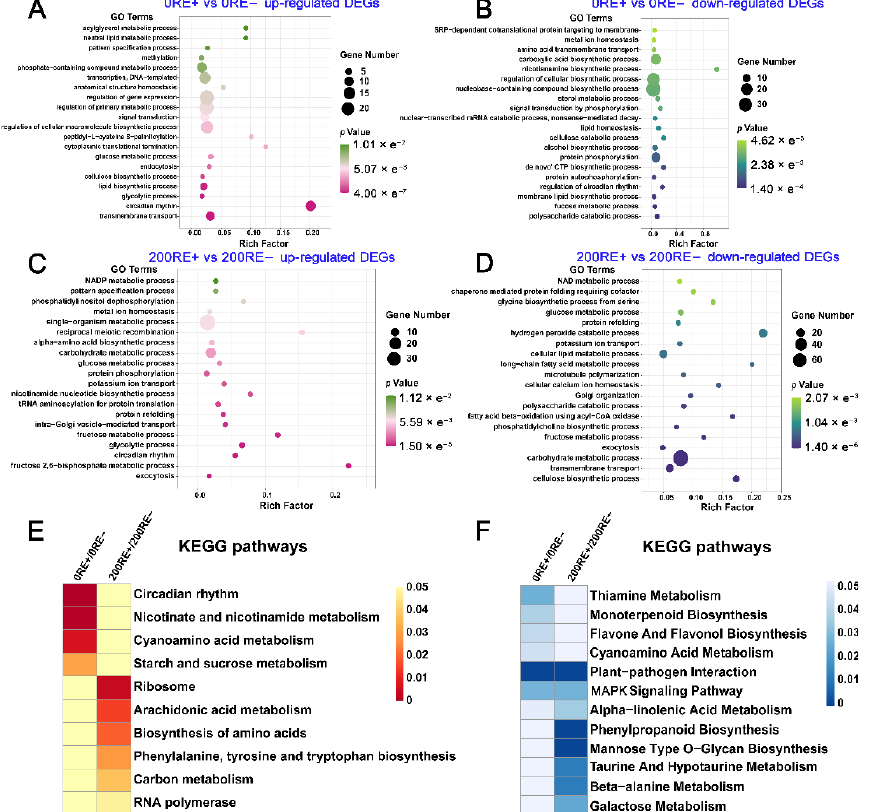
Figure 3. Gene ontology (GO) and KEGG pathway enrichment analysis of DEGs that identified be- tween E+ and E − host roots at 0 and 200 mM NaCl concentrations. The GO terms of up-regulated ( A ) and down-regulated ( B ) DEGs between 0RE+ and 0RE − , The GO terms of up-regulated ( C ) and down-regulated ( D ) DEGs between 200RE+ and 200RE − . “Rich factor” represents the ratio of the enriched DEGs to the total genes annotated in the corresponding pathway. KEGG pathway enrichment analysis of up-regulated ( E ) and down-regulated ( F ) DEGs identified between roots of E+ and E − plants under 0 and 200 mM NaCl concentrations. Color panels show the p -value of KEGG pathway enrichment among the comparisons.